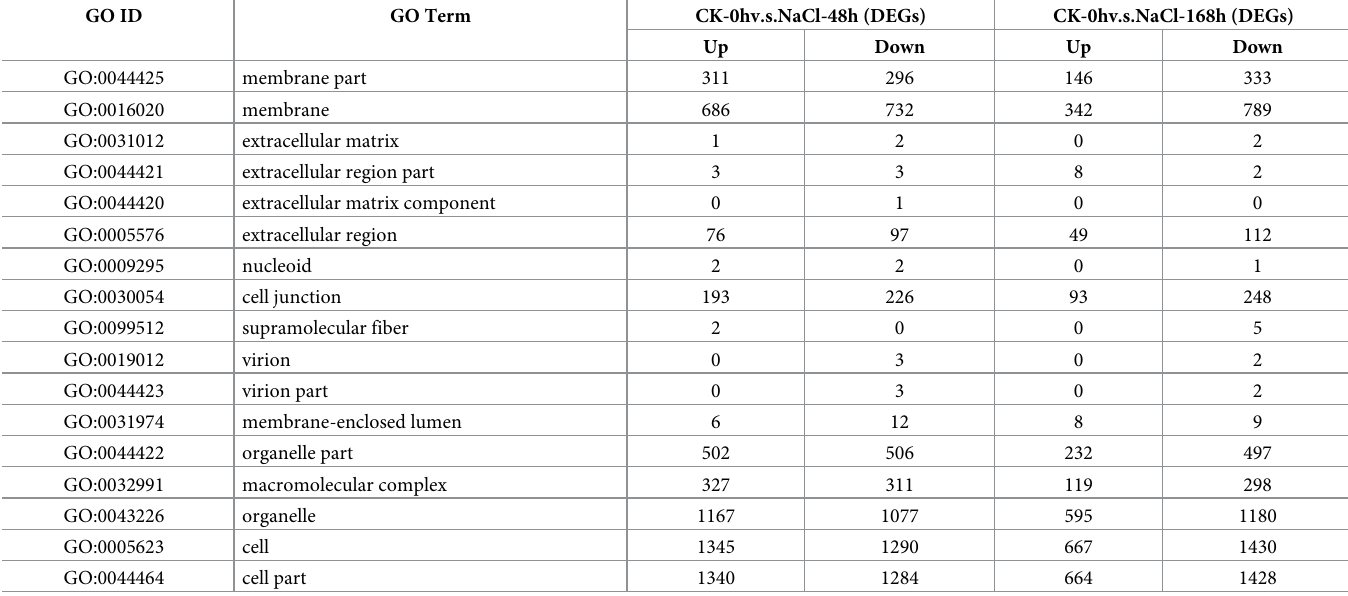
Table 4. GO enrichment analysis of cellular component of